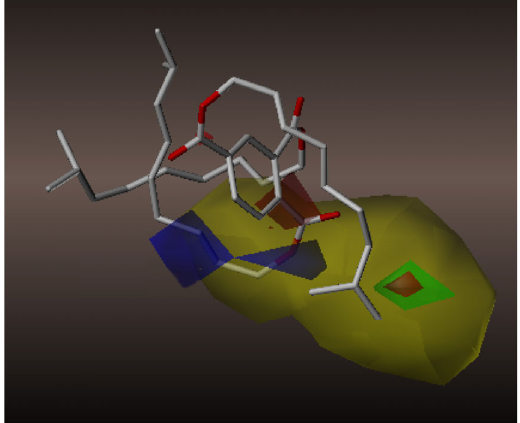
CoMSIA contour diagram for wear with embedded triisodecyl trimellitate as reference for both steric and electrostatic fields. Green and yellow regions show where steric bulk is favored and disfavored, respectively. Blue region shows where positive charge is favored while red region shows where negative charge is